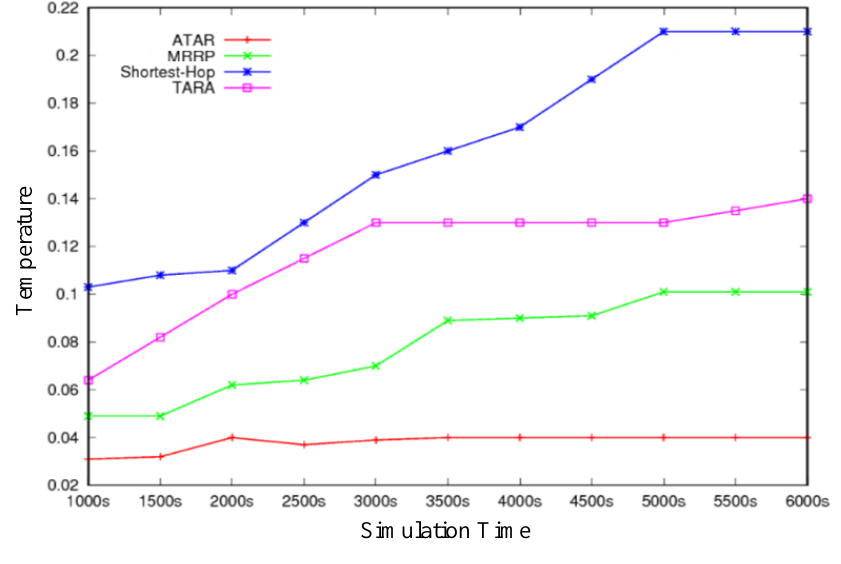
Figure 18. Maximum temperature rise versus simulation